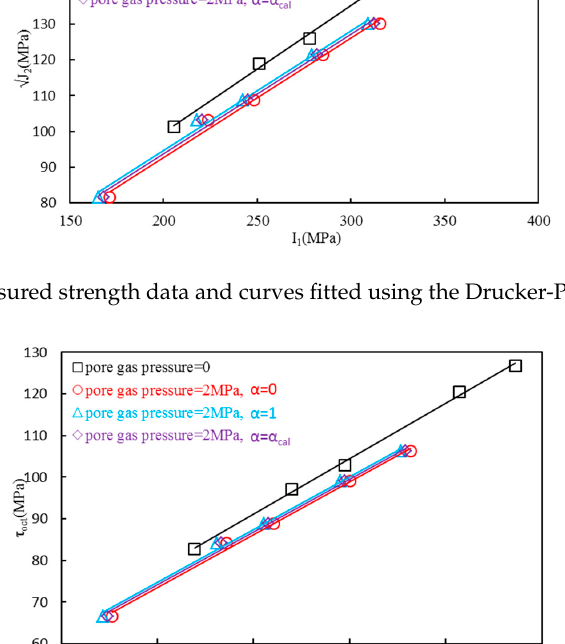
Figure 12. Measured strength data and curves fitted using the linear Mogi criterion.